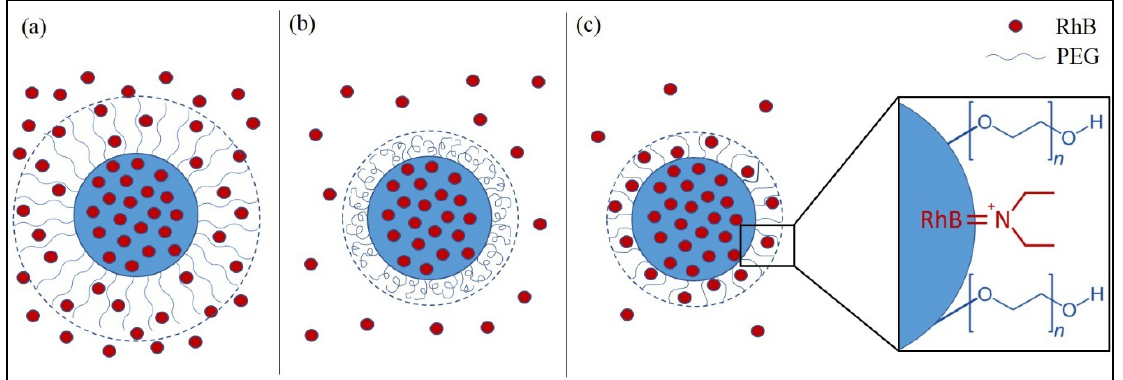
Figure 1. Scheme of possible conformation of loaded-PNPs before ( a ) and after purification processes with centrifugation ( b ) and dialysis ( c ).